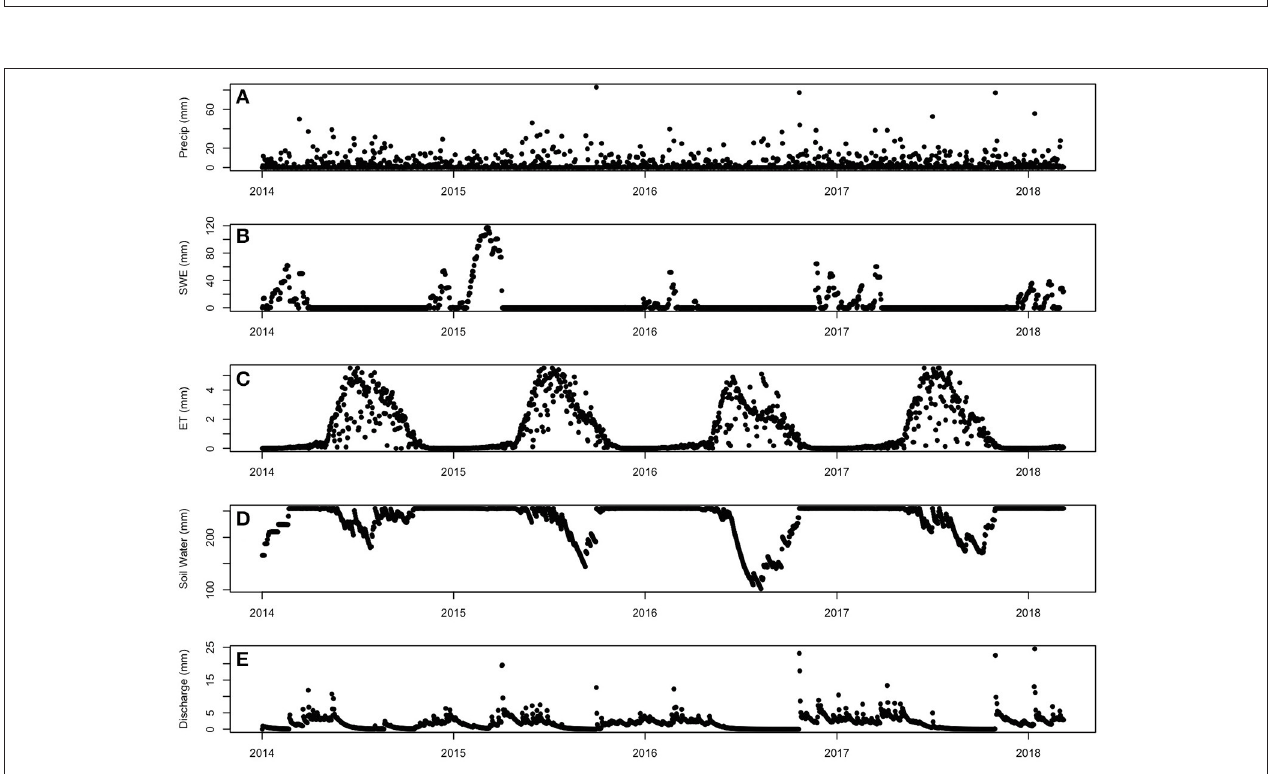
FIGURE 3 | Daily precipitation data (A) used to model SWE (snow water equivalent) (B) , ET (evapotranspiration) (C) , soil water (D) , and discharge (E) . All plots include both pre- and post-BMP sampling regimes. Pre-BMP sampling occurred 2014–2015, post-BMP sampling corresponds to 2017–2018.